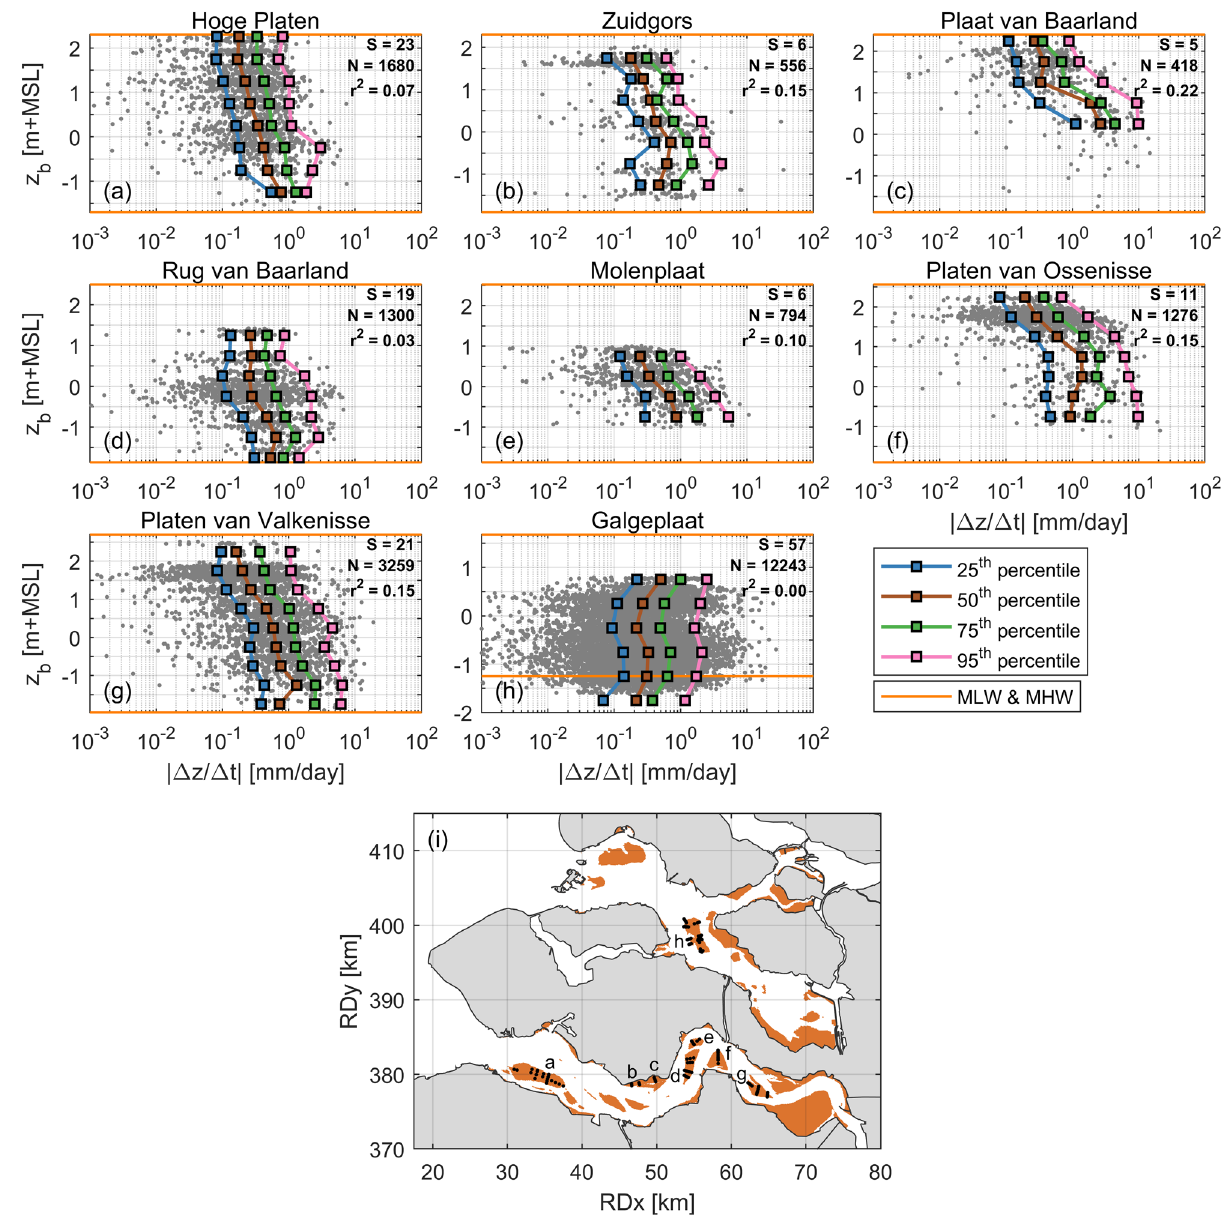
see ( i ) for the location of intertidal flats a–h with the measurement locations indicated as black markers. The number of measurement locations for each flat (S), the total number of samples (N) and the coefficient 2 of determination ( r ) are shown in the top right corner for each flat. The horizontal grid lines represent the boundaries of the vertical bins over which the percentiles are computed. Percentiles are only shown for vertical bins that contained at least 20 data points. All plots are vertically bounded by mean low water (MLW) and mean high water (MHW), apart from ( h ) that contained also a substantial amount of data points below MLW. Absence of data at the top of the tidal window in ( d ), ( e ), and ( h ) is due to the limited height of these flats, while absence of data at the bottom of the tidal window is solely due to absence of measurements at those elevations. All data is shown versus a fixed reference frame (the 2014 mean sea level;